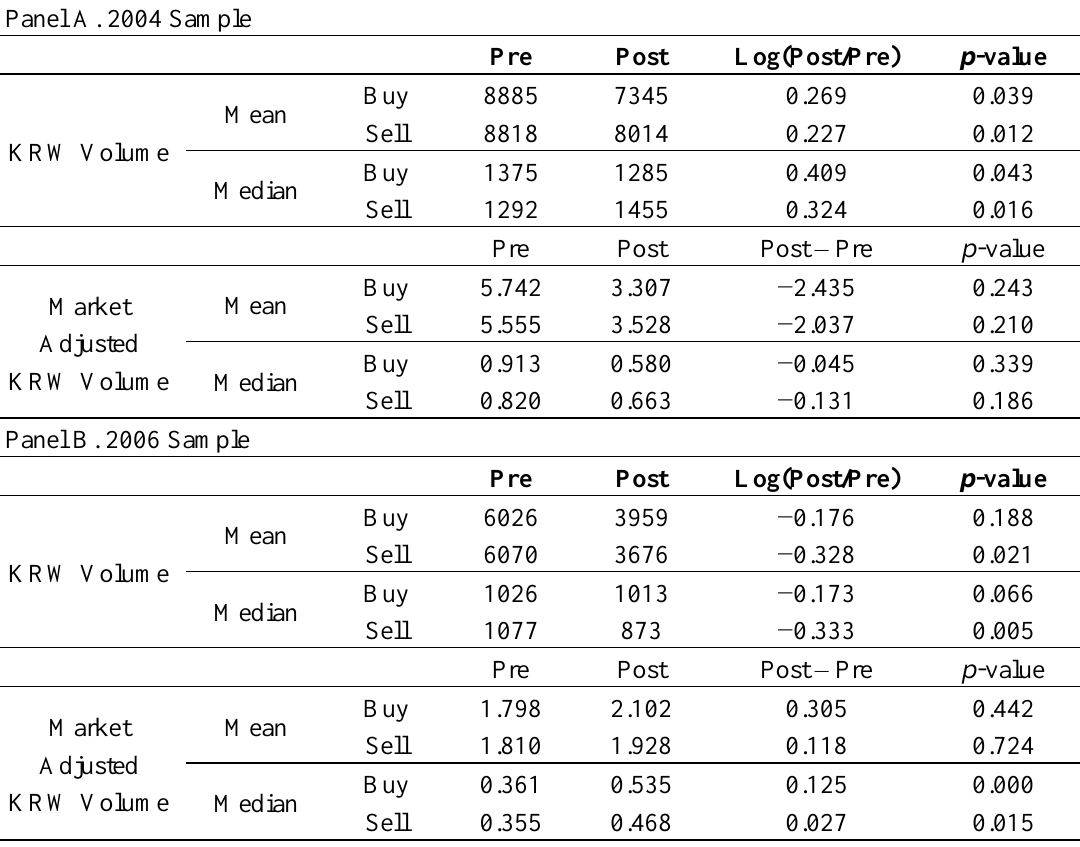
Table 4. KRW volume around MTU